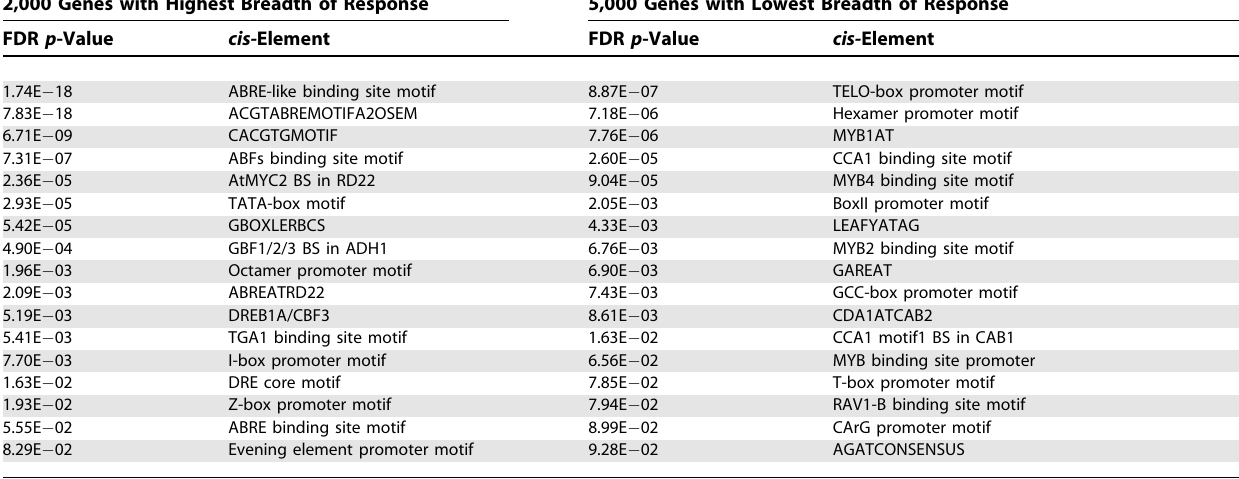
Table 3. cis -Regulatory Elements (Motifs) Associated with Genes with High (Left) versus Low (Right) Breadth of Differential Gene Response and vice versa at Significance Level of FDR p- Value ,